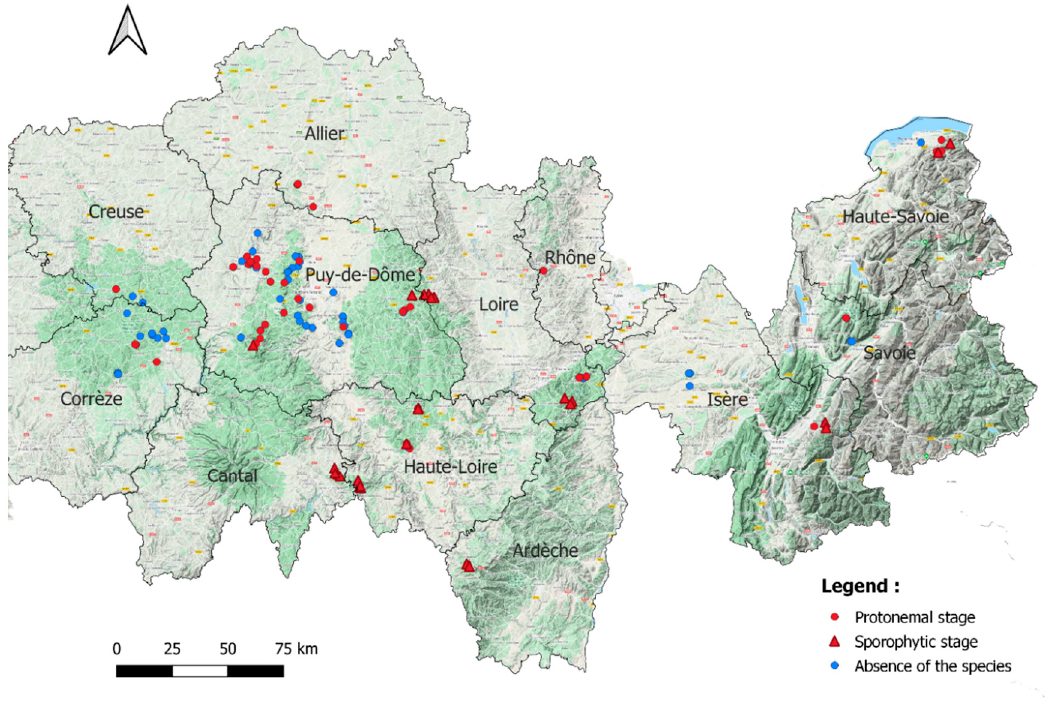
Figure 1. All 137 habitats (forest stands) surveyed. Black lines: French departments limits. © Google